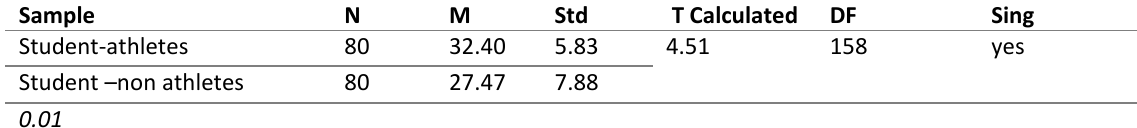
Table 2. Significance of differences in the mental health level of the tested sample Sample N M Std T Calculated DF